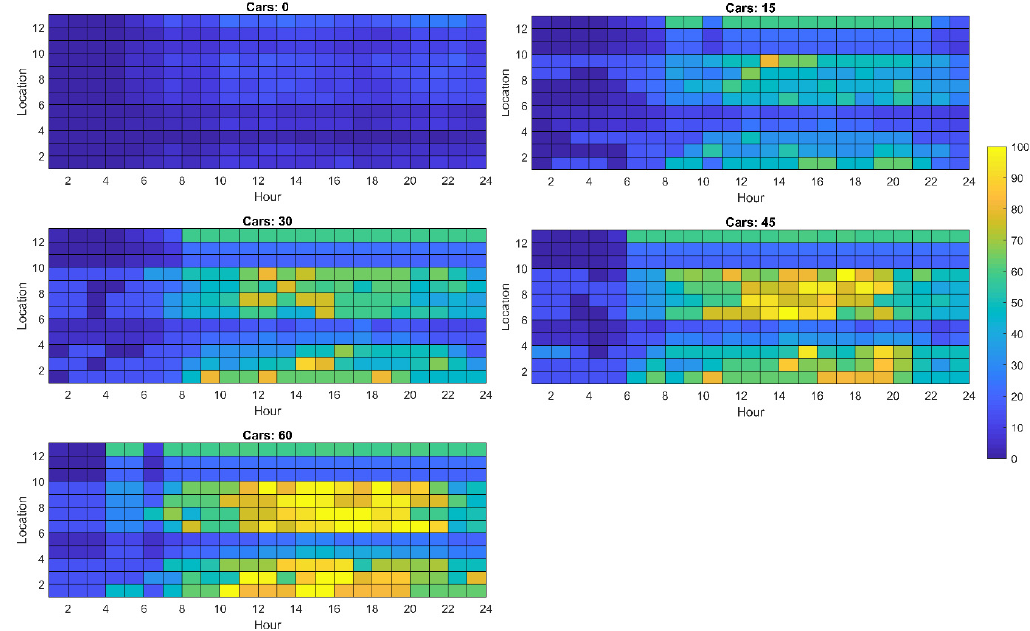
Energies 2021 , 14 , x FOR PEER REVIEW Figure A7. Maximum line loading (percentage) observed in network 3 with distributed generation ON.